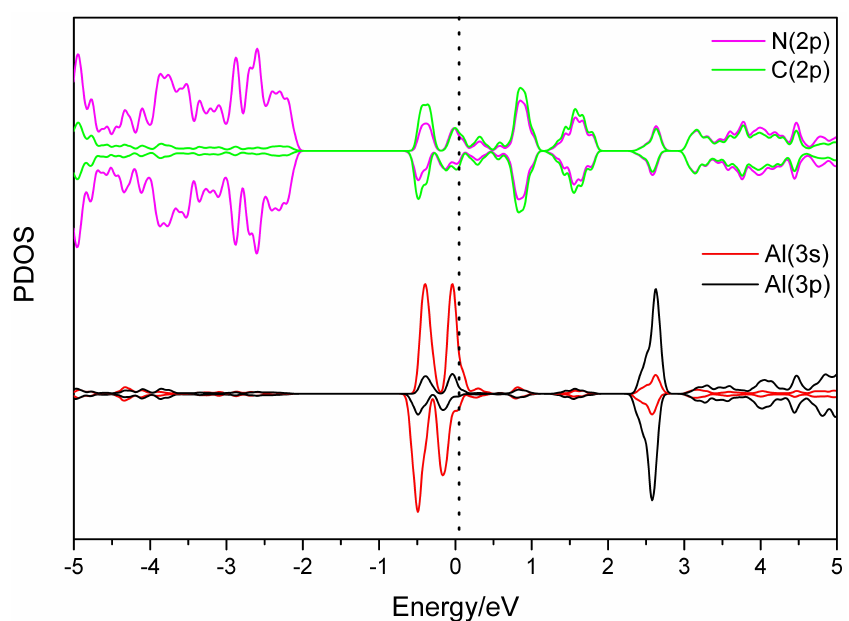
N for selected N, C and Al atoms. The energy is plotted 3 4